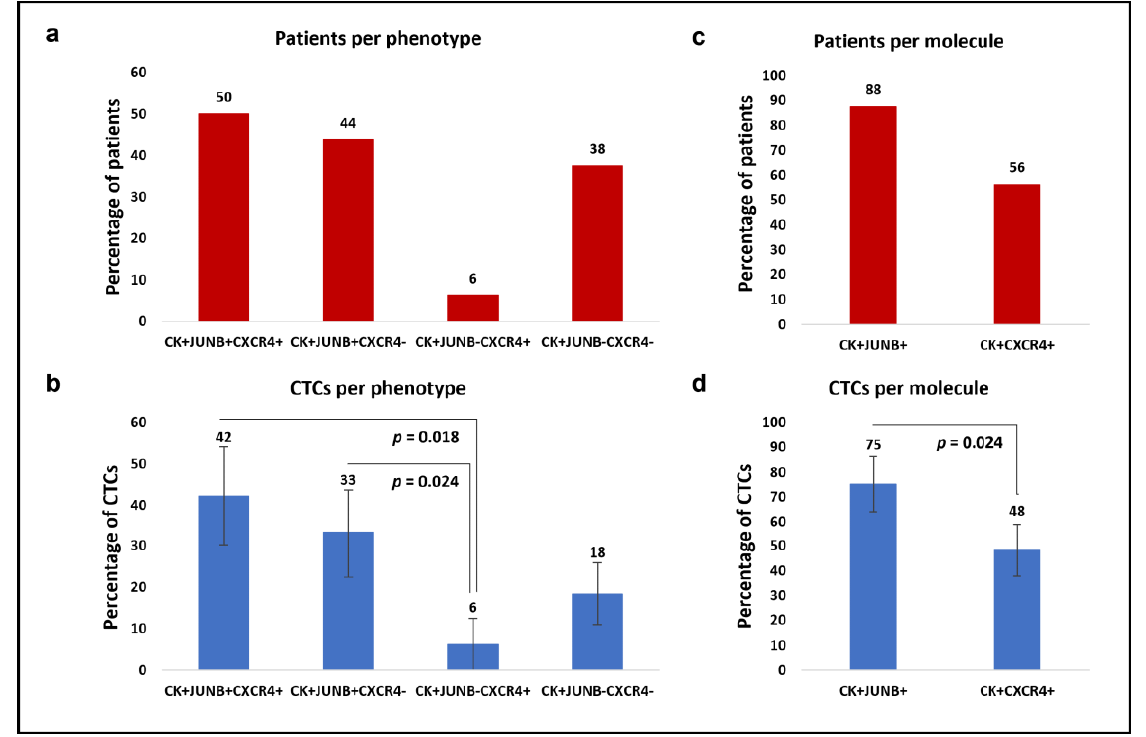
Figure 2. Phenotypic patterns of (CK/JUNB/CXCR4) expression in NSCLC blood samples. ( a ) Per- centages of patients with (CK+/JUNB+/CXCR4+), (CK+/JUNB+/CXCR4 – ), (CK+/JUNB – /CXCR4+) and (CK+/JUNB – /CXCR4-) phenotypes. ( b ) Average percentages of the total CTCs with the identi- fied (CK+/JUNB+/CXCR4+), (CK+/JUNB+/CXCR4 – ), (CK+/JUNB – /CXCR4+) and (CK+/JUNB – /CXCR4 – ) phenotypes. ( c ) Percentages of patients with (CK+/JUNB+) and (CK+/CXCR4+) phenotypes. ( d ) Average percentages of the total CTCs with (CK+/JUNB+) and (CK+/CXCR4+) phenotypes.